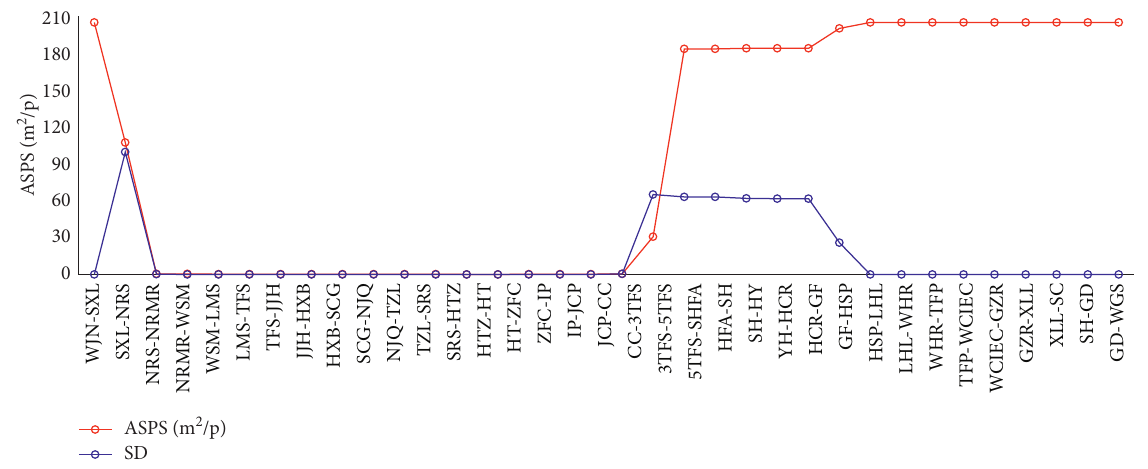
Figure 12: Average space per standee and standard deviation on links of line 1 (AM).